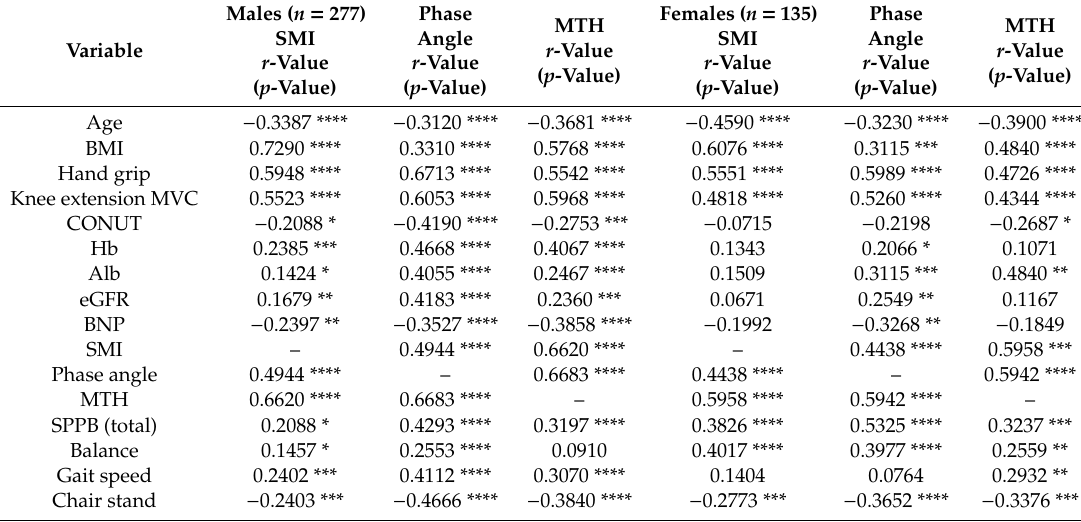
Table 2. Correlations between the SMI, phase angle, anterior thigh muscle thickness, and clinical variables.